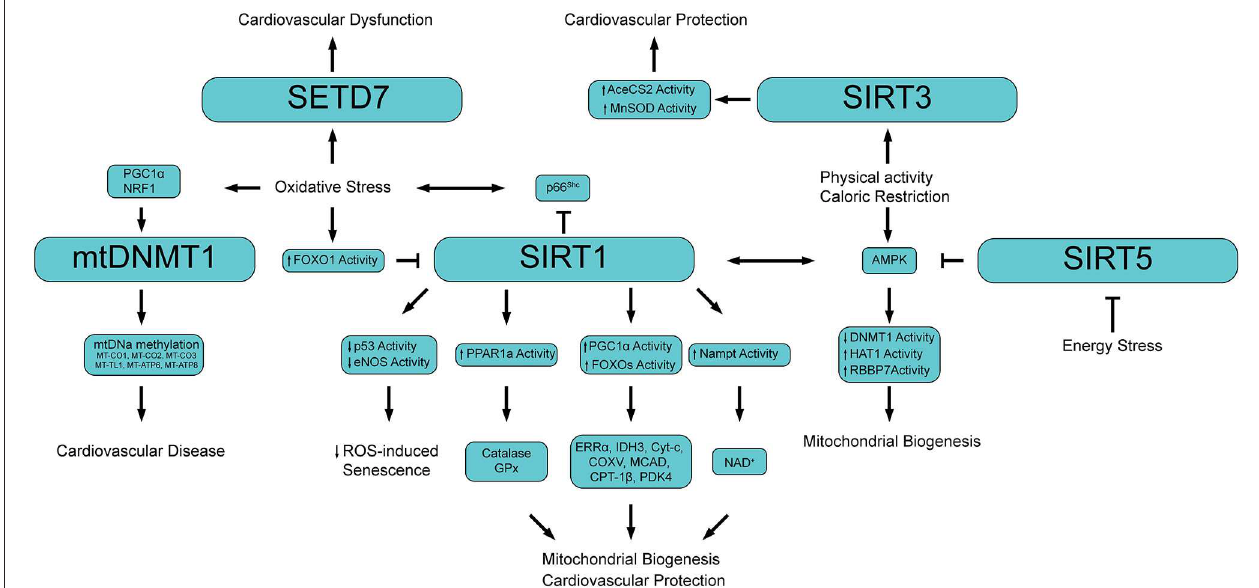
FIGURE 3 | Schematic showing the main epigenetic networks regulating mitochondrial functionality and cardiovascular disease. PGC1 α , Peroxisome proliferator-activated receptor gamma coactivator 1-alpha; NRF1, Nuclear respiratory factor 1; mtDNMT1, Mitochondrial DNA methyltransferase 1; MT-CO (1-3), Cytochrome c oxidase subunit (I, II, III); MT-TL1, Mitochondrially encoded tRNA-Leu 1; MT-ATP (6, 8) Mitochondrially encoded ATP synthase membrane (subunit 6, 8); FOXO1, Forkhead box O3; PPAR1a, Peroxisome proliferator-activated receptor 1 alpha; GPx, Glutathione peroxidase; ERR α , Estrogen-related receptor alpha; IDH3, isocitrate dehydrogenase 3; Cyt-c, Cytochrome c; COXV, Cytochrome c oxidase subunit 5; MCAD, Medium-chain acyl-CoA dehydrogenase; CPT-1 β , Carnitine Palmitoyltransferase 1 beta; PDK4, Pyruvate dehydrogenase lipoamide kinase isozyme 4; Nampt, Nicotinamide phosphoribosyltransferase; NAD + , Nicotinamide adenine dinucleotide; AceCS2, acetyl-CoA synthetase 2; AMPK, 5 ′ adenosine monophosphate-activated protein kinase; HAT1, Histone acetyltransferase 1; RBBP7, Retinoblastoma binding protein